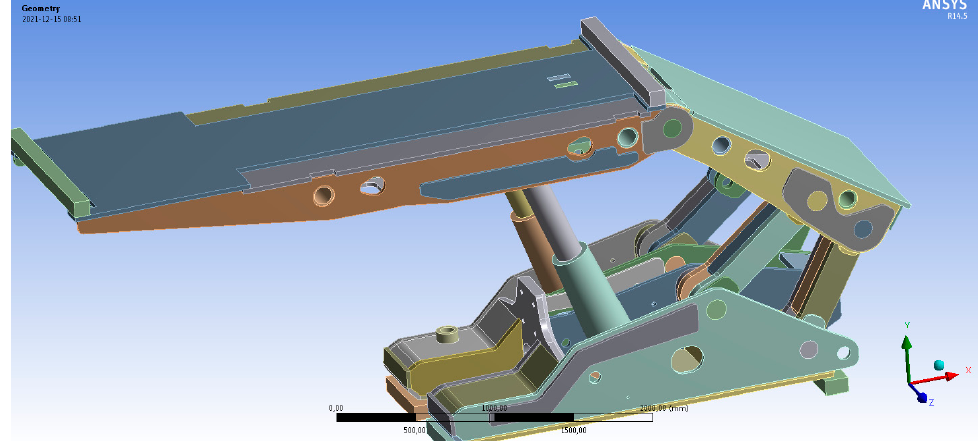
Figure 3. The 3D model of the support section.